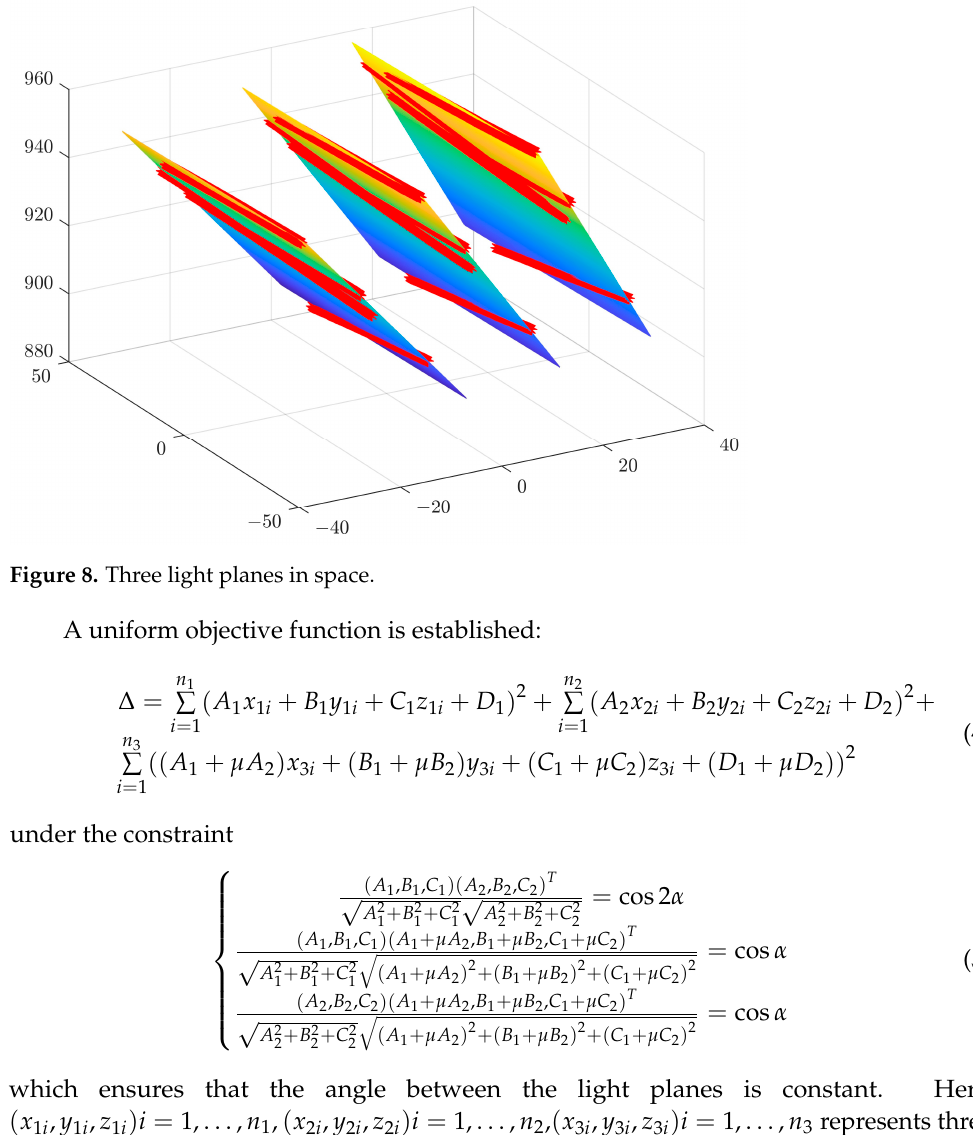
Figure 9. Detect the pixel coordinates of the intersection point.